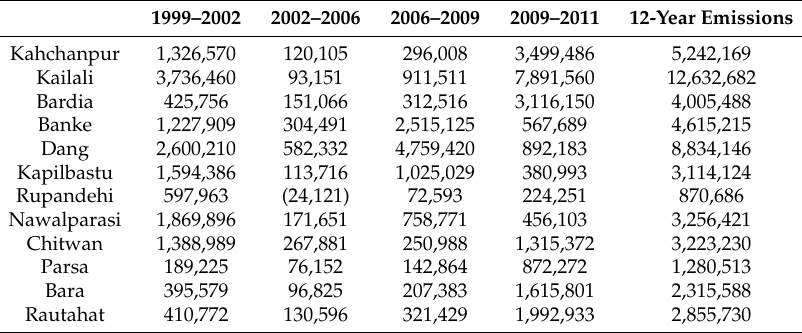
Table 8. Total CO 2 emission (tCO2e) by districts for 4 time